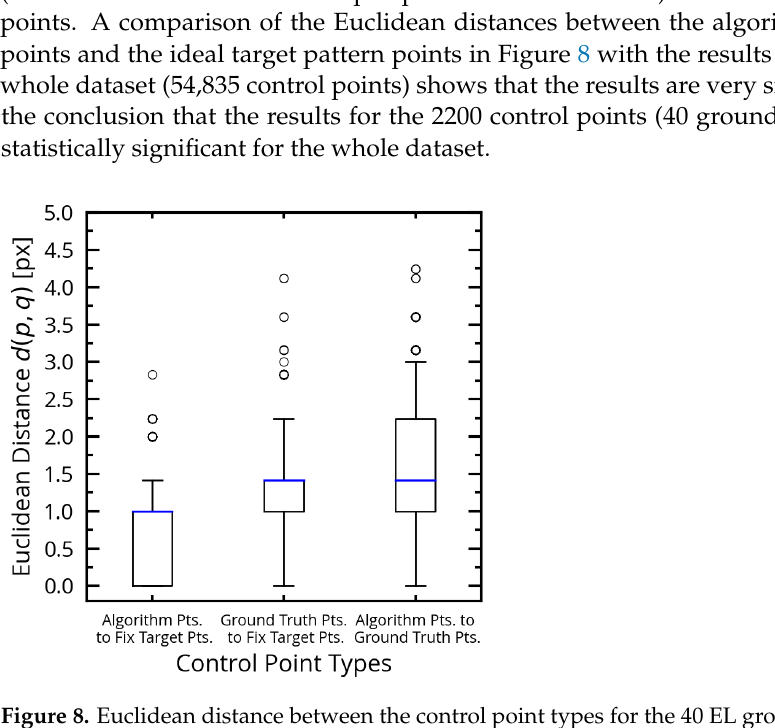
Figure 8. Euclidean distance between the control point types for the 40 EL ground truth EL images (2200 control points). The whisker lengths indicate 0% percentile to 99%